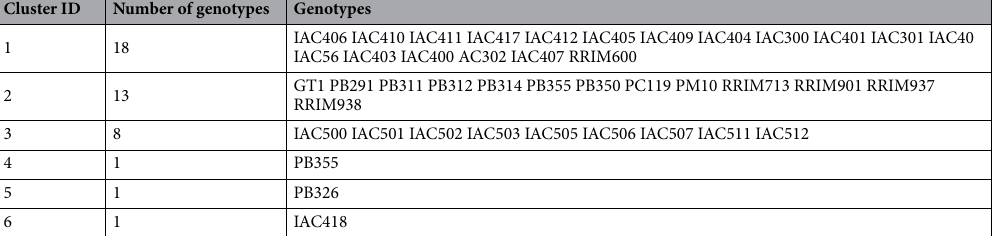
Table 1. Classification of 44 rubber tree genotypes into different clusters on the basis of divergence.